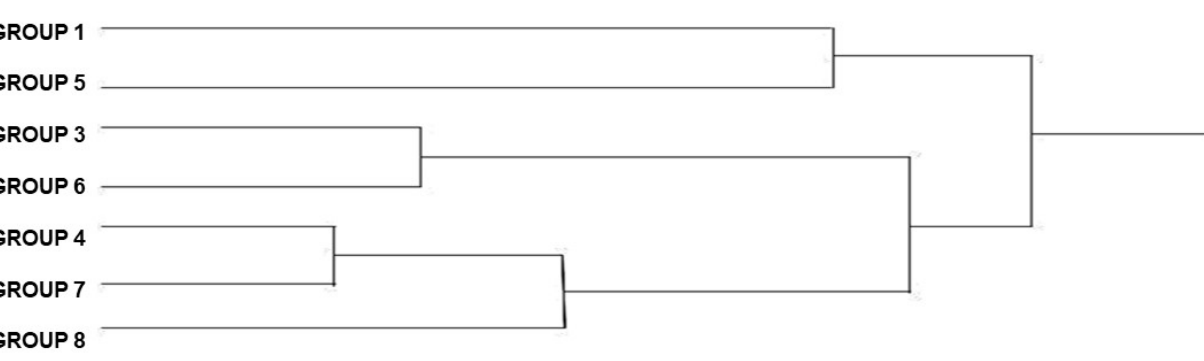
Figure 3. UPGMA dendrogram of the Triatoma brasiliensis brasiliensis females, from various states and